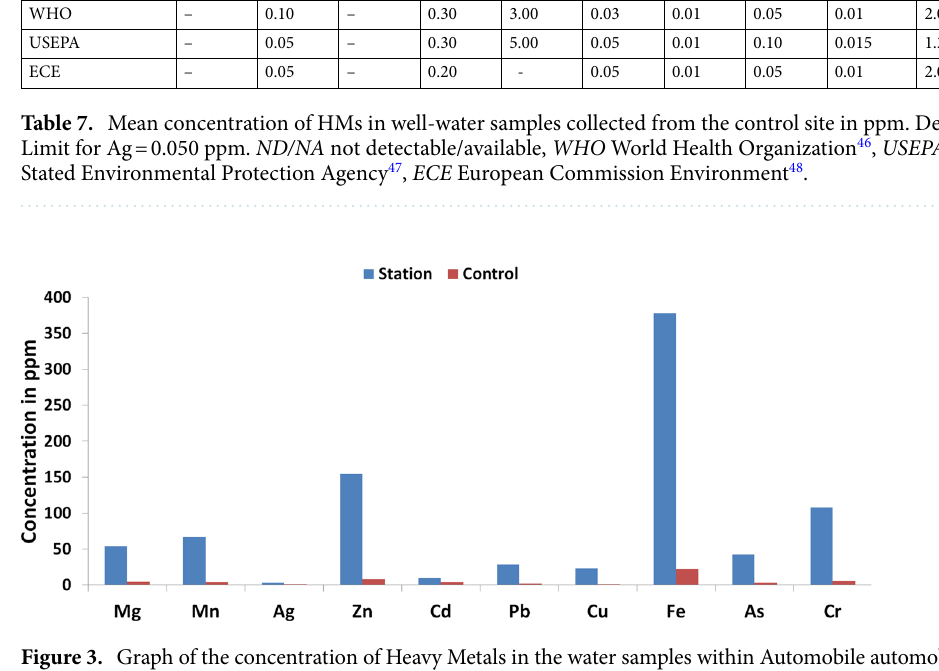
Figure 3. Graph of the concentration of Heavy Metals in the water samples within Automobile automobile spare part and recycling park and control